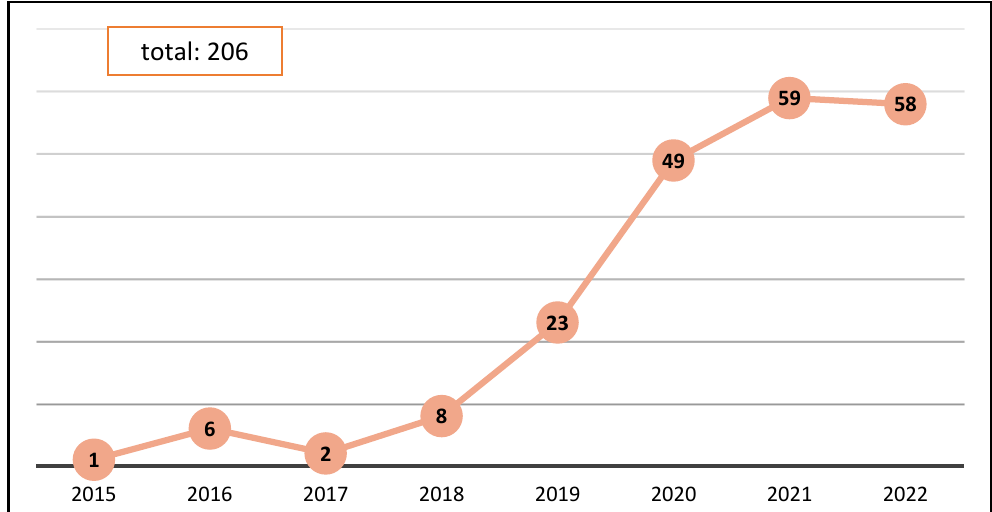
Figure 2. The number of papers published in consecutive years in the areas of electricity grid flexibility and prosumer participation.